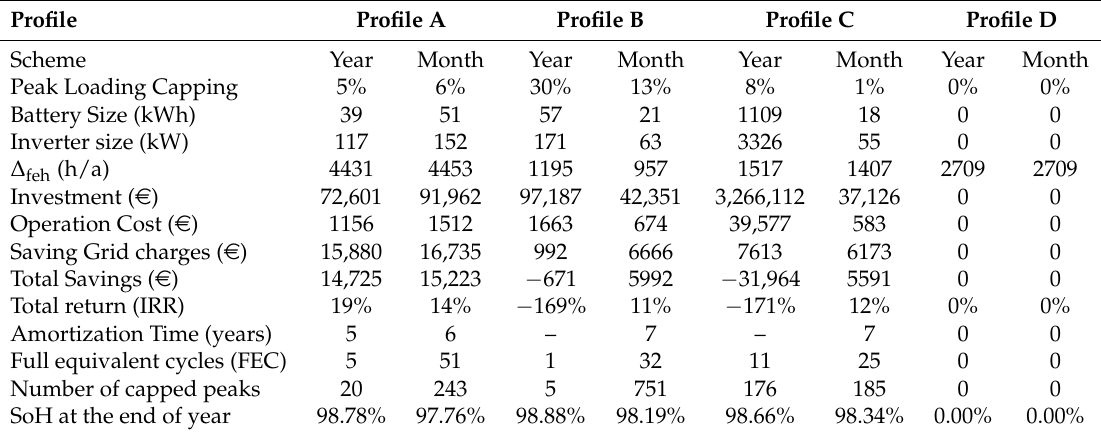
Table 4. Economical and technical comparison of system optimization